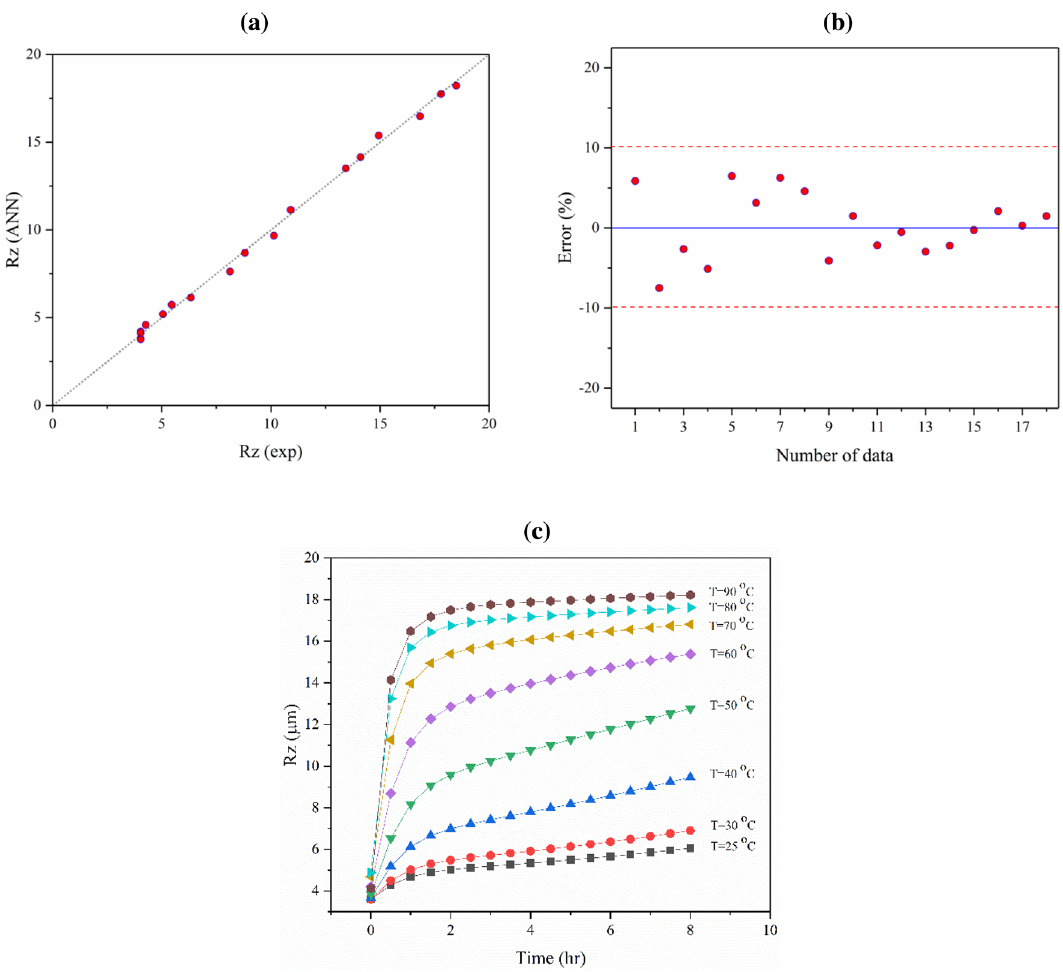
Figure 8. ( a ) Quality line, ( b ) the error values for experimental data and ANN model (R = 9970) outputs of R z , and ( c ) the effect of time and temperature variation on the R z of the titanium surface after etching with an